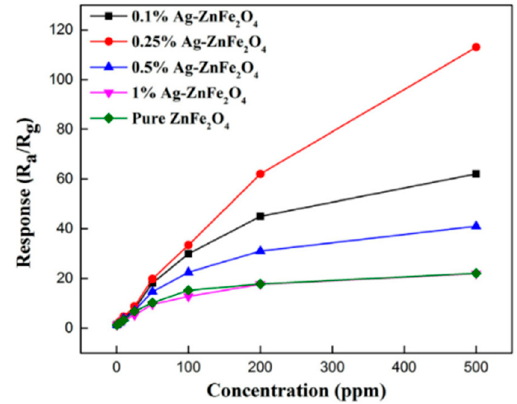
Figure 19. The responses of Ag-ZnFe 2 O 4 sensors to 0.8–500 ppm acetone vapor [83].